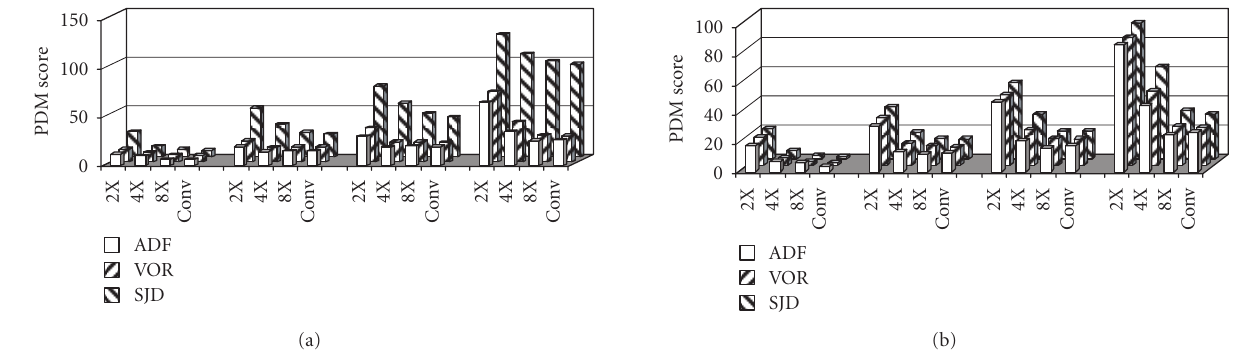
Figure 6: Reconstruction methods with di ff erent noise levels and sampling densities. PDM scores are plotted as a function of di ff erent DCFs and regridding methods, at 4 noise levels. In (a), images were acquired with a single-shot and sampling density = 0 . 8. In (b), images were acquired with interleaves = 17 and sampling density = 0 . 9.